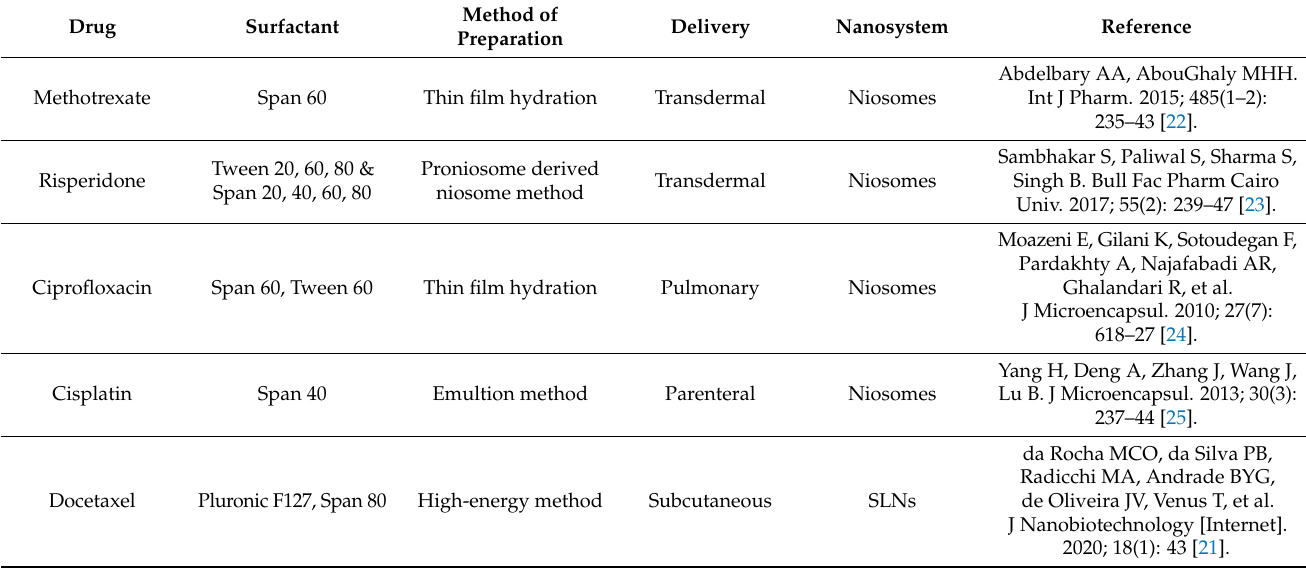
Table 2. Examples of nanoparticle surfactant drug delivery